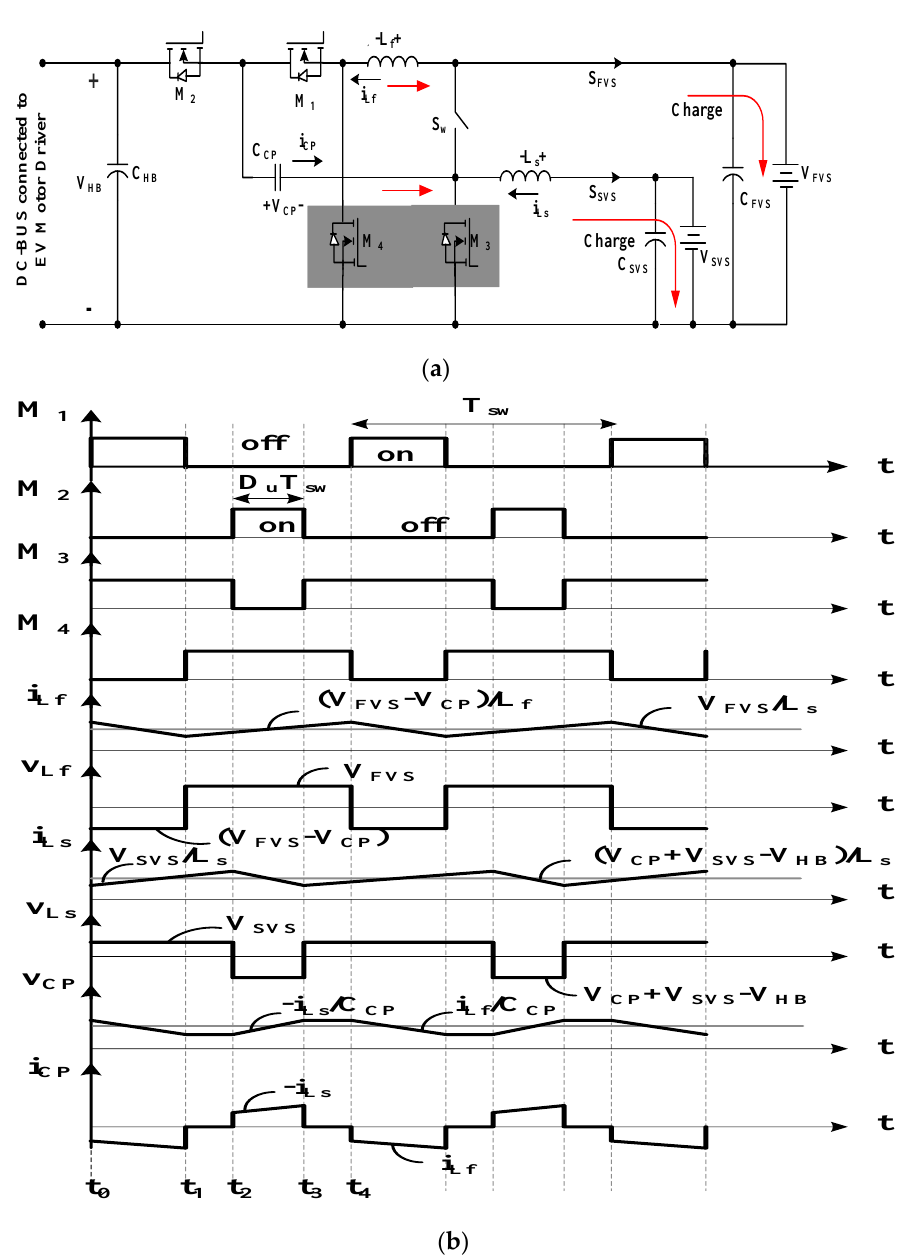
Figure 5. ( a ) Schematic Diagram. ( b ) Waveforms of BDC’s DC-bus high voltage energy-regenerative mode.